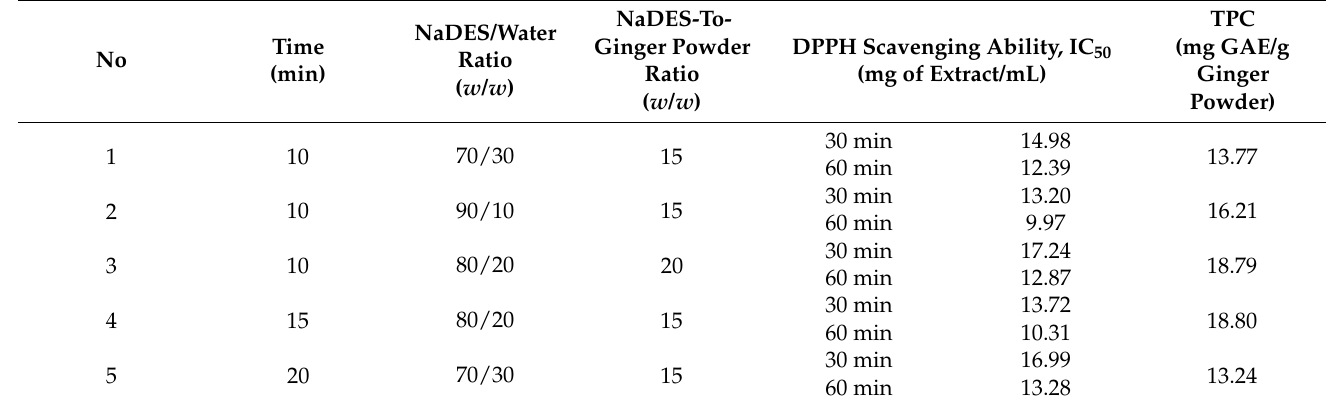
Table 2. NaDES-UAE preliminary experiments.